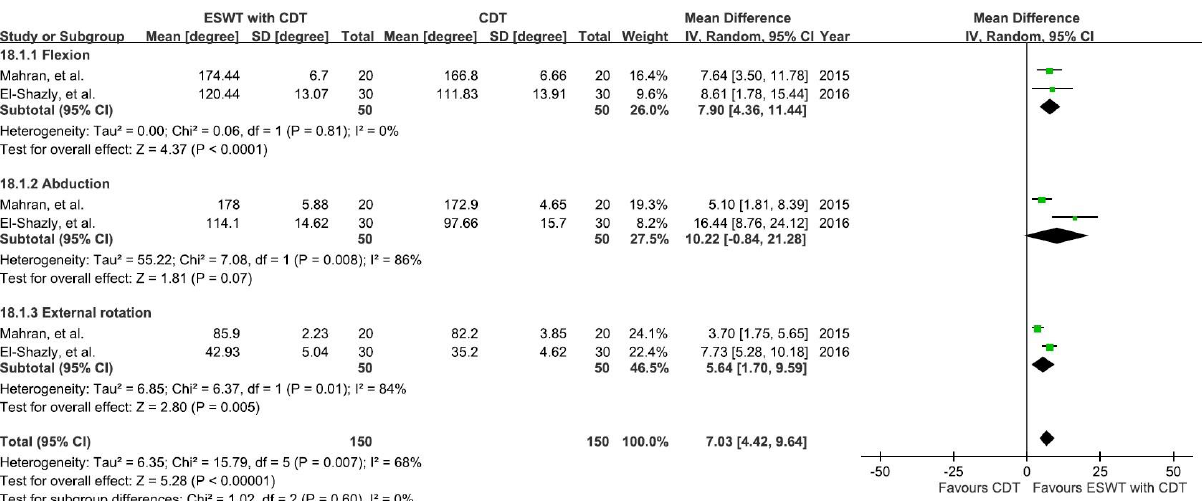
Figure 7. Mean difference (95%CI) in the effect of additional ESWT compared with CDT alone on the shoulder ROM of BCRL.